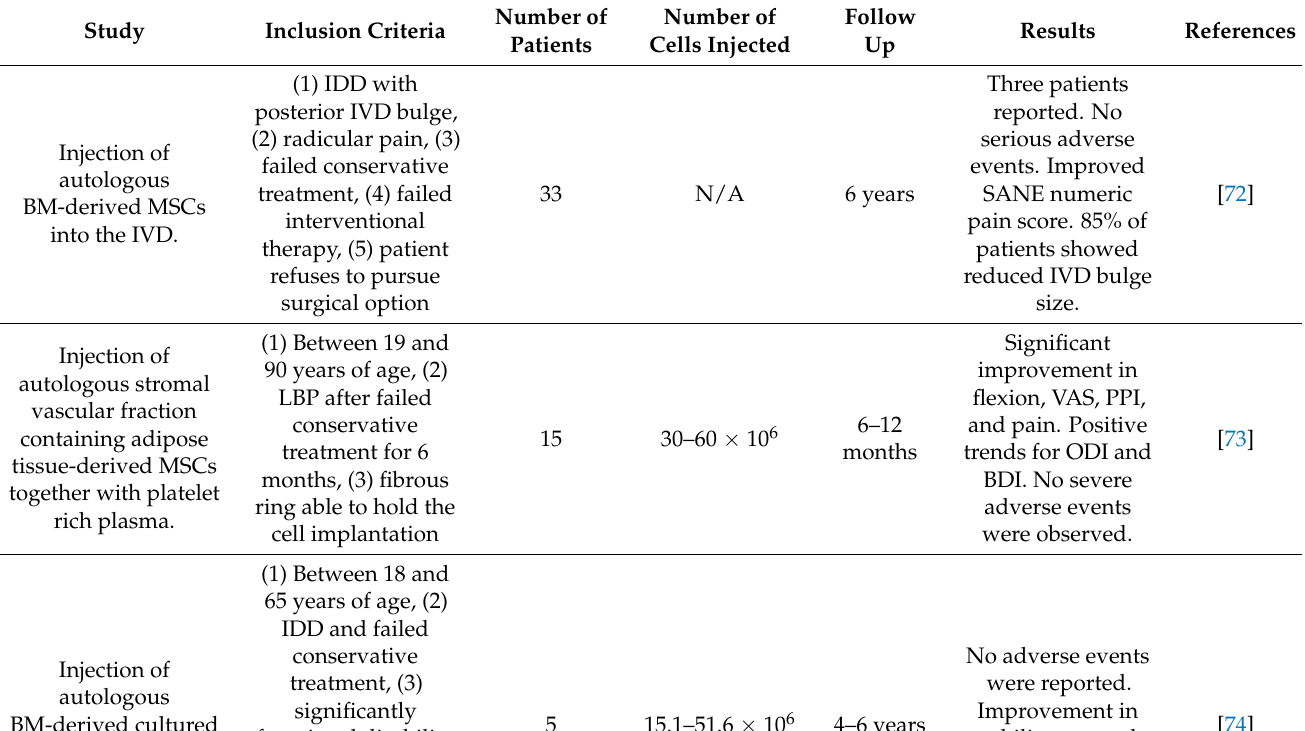
Table 2. Published clinical studies related to intradiscal transplantation of